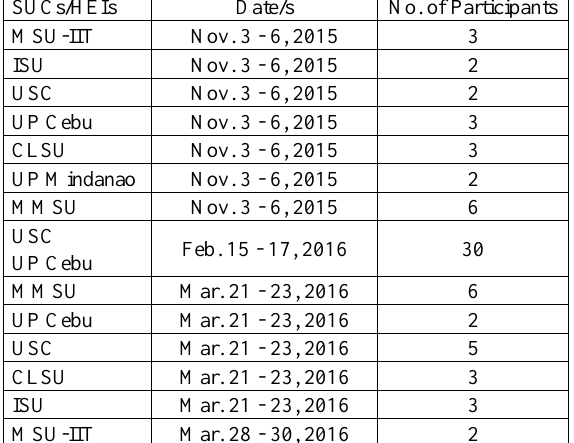
Table 4. Mentoring sessions conducted by